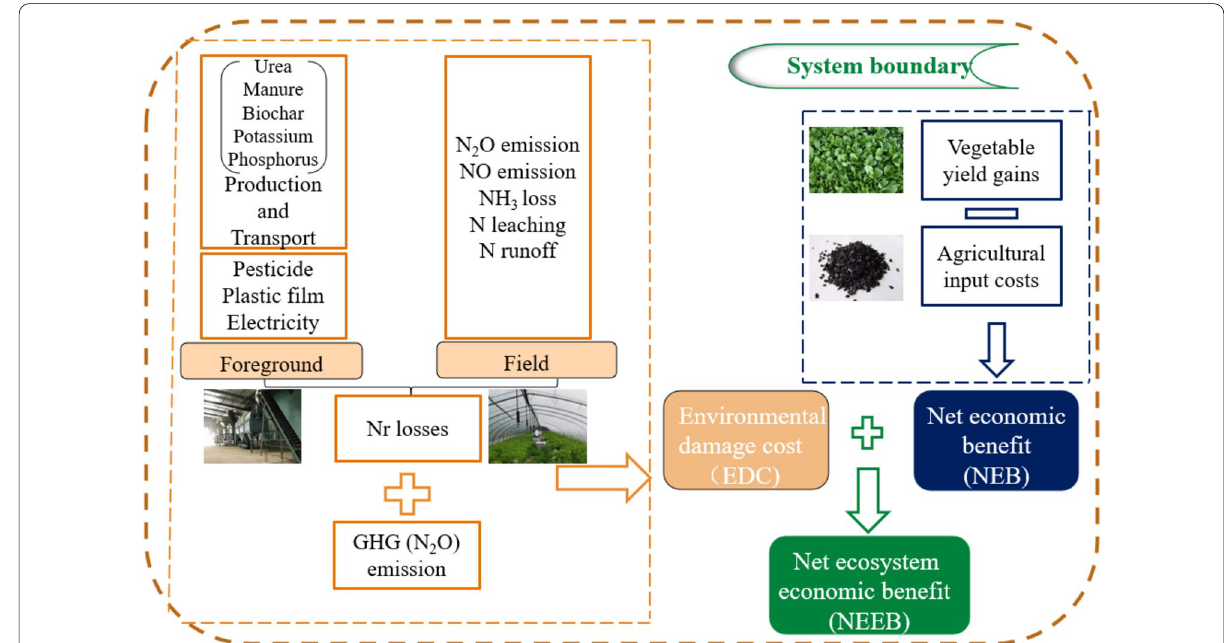
Fig. 1 System boundaries for the life cycle assessment of net ecosystem economic benefit (NEEB) in intensive vegetable